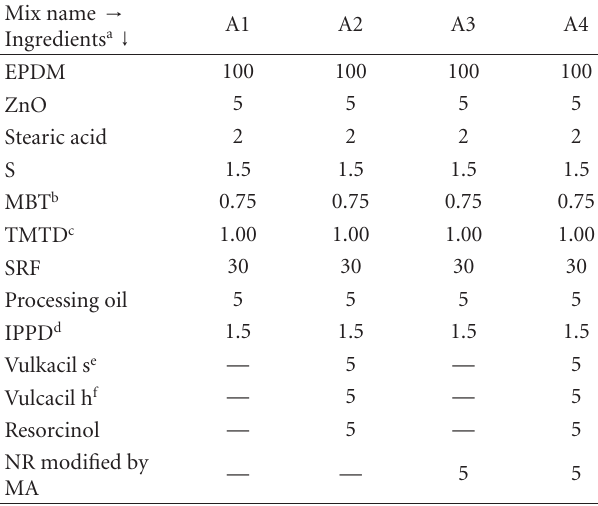
Table 1: EPDM mix formulation containing Vulkasil s, Vulcacil h, resorcinol, and NR modified by